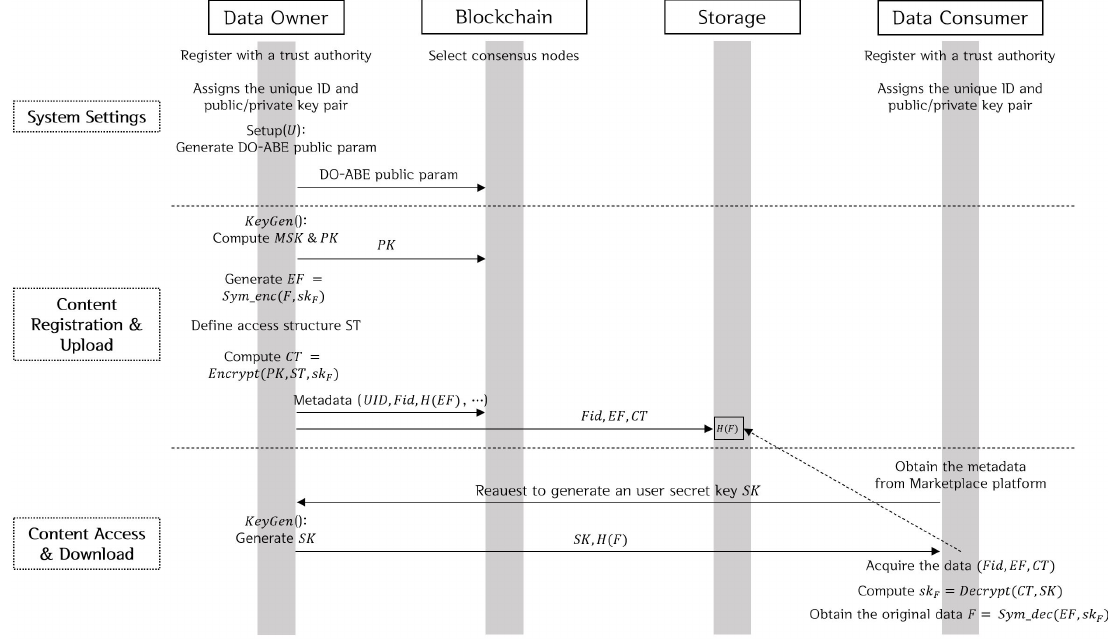
Figure 5. Data Sharing and Trading Process using Blockchain-based